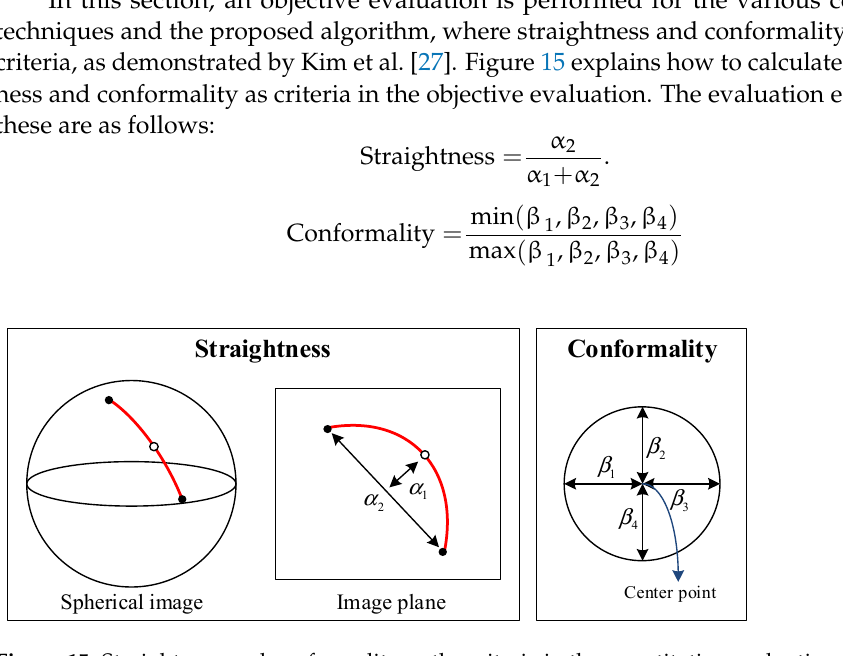
. F Table 1. Degradation evaluated with (44) for the various techniques. h